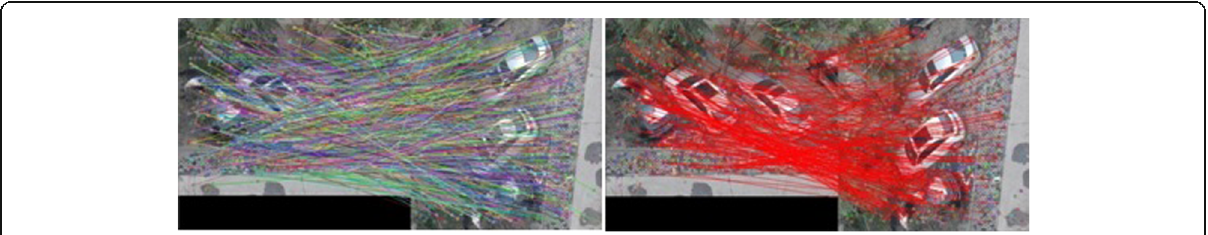
Fig. 4 BRISK algorithm for the same-scale image feature detection